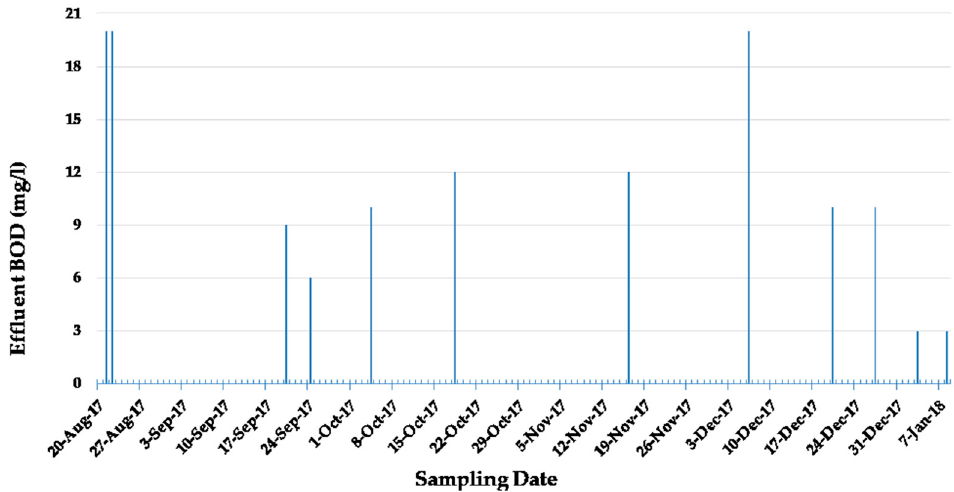
Figure 4. Effluent biological oxygen demand (BOD) results of samples collected from 21 August 2017 to 8 January 2018.